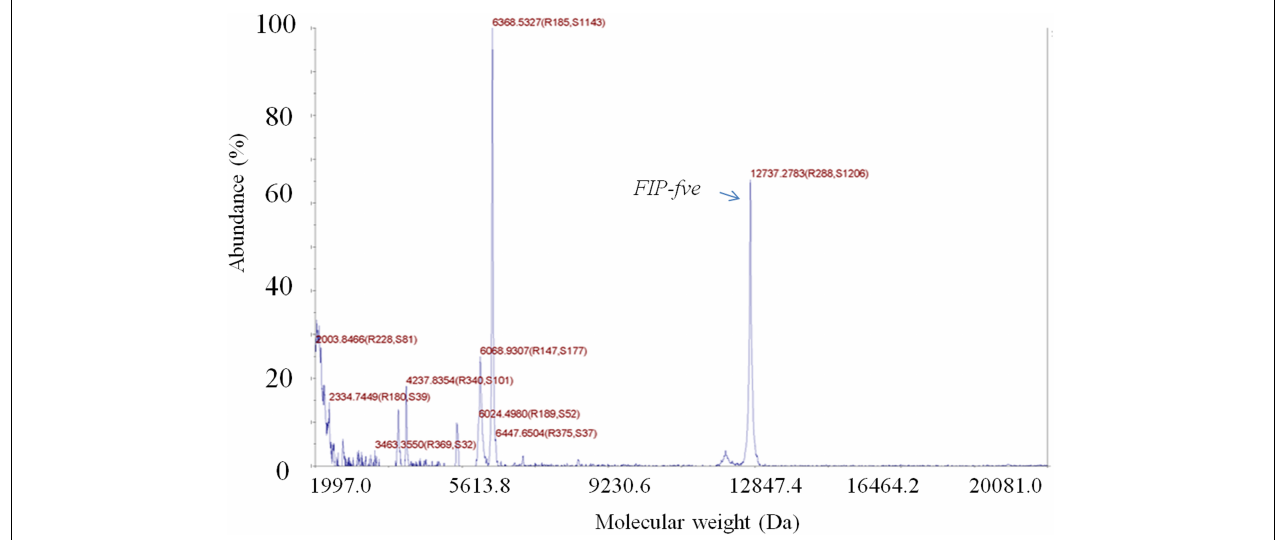
FIGURE 1 | FIP-fve is detected by MALDI-TOF/TOF. The molecular weight of FIP-fve was measured by matrix-assisted laser desorption ionization time-of-flight mass spectrometry in a positive ion mode, with the calibration ranges of the linear medium molecular weight calibration materials being 5,737.609 + 50, 12,362 + 50, and 16,952 +